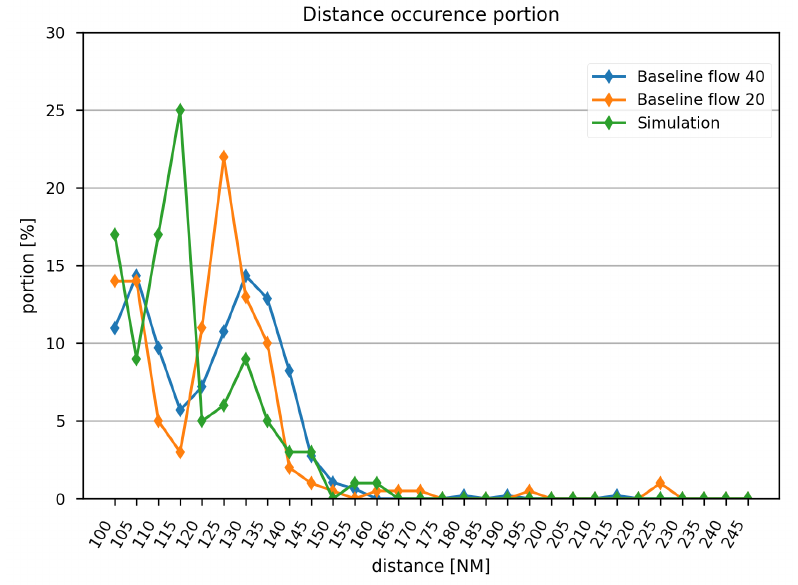
Figure 8. Cumulative occurrence curve for flight-distance results obtained in validation trials (green) and real traffic reference values for flows of 40 aircraft per hour (blue) and 20 aircraft per hour